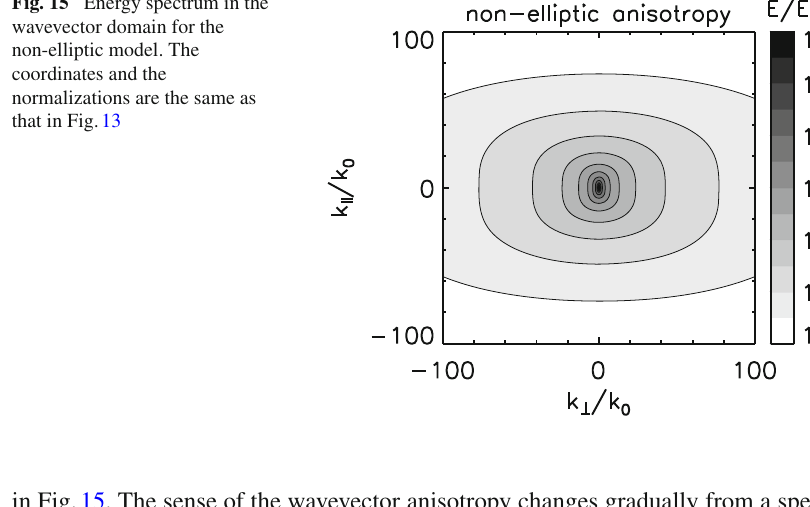
Fig. 15 Energy spectrum in the wavevector domain for the non-elliptic model. The coordinates and the normalizations are the same as that in